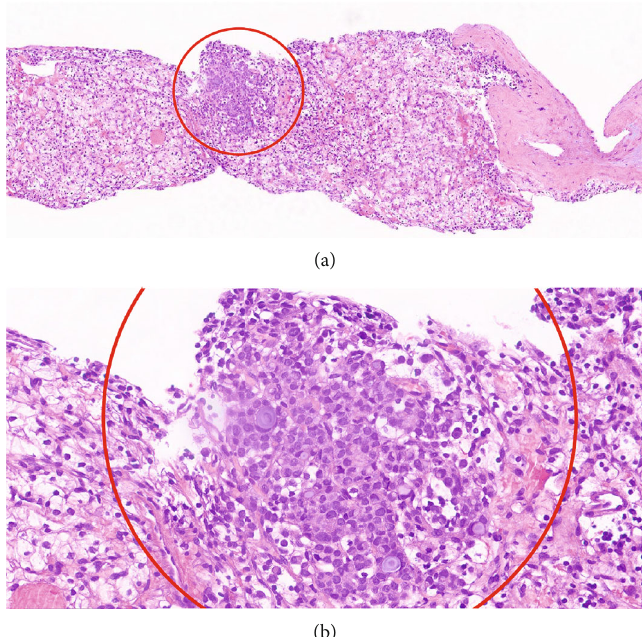
Figure 3: Metastatic in fi ltrating lobular breast carcinoma involving ccRCC. (a) At 40X, the encircled metastatic breast carcinoma focus is surrounded by ccRCC. (b) At 200X, intracytoplasmic mucin is apparent.